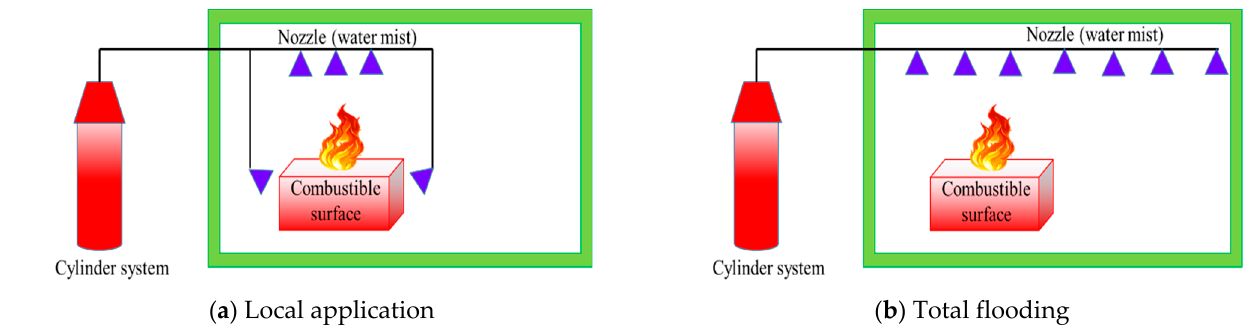
Figure 1. Water mist fire suppression general arrangement.